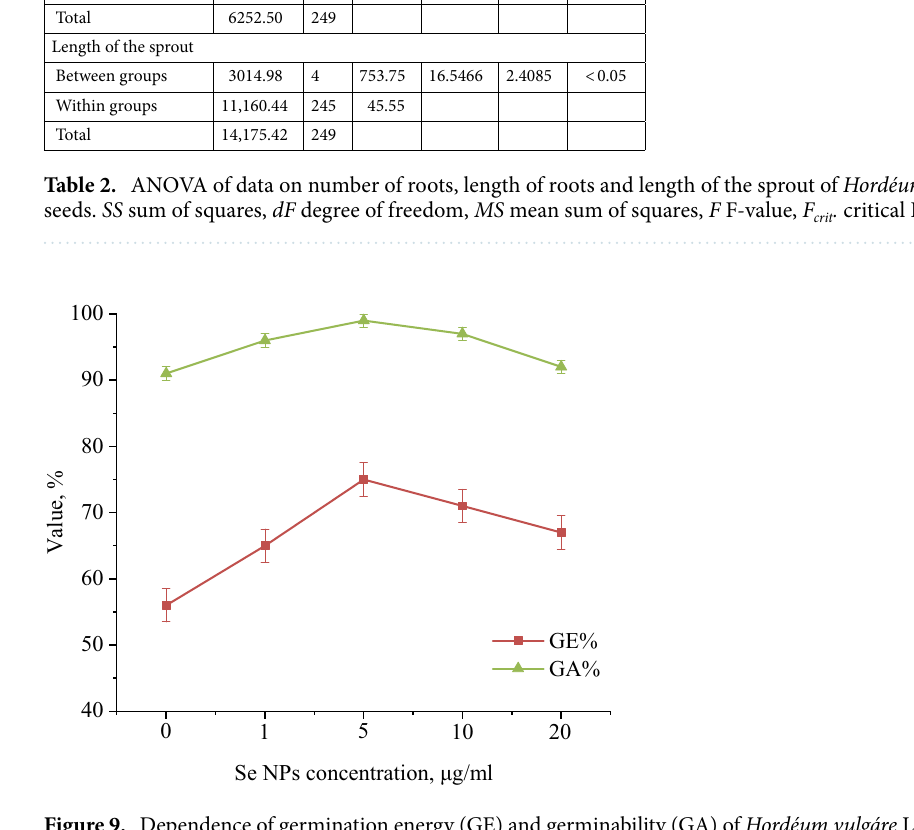
Figure 9. Dependence of germination energy (GE) and germinability (GA) of Hordéum vulgáre L. seeds on Se NPs